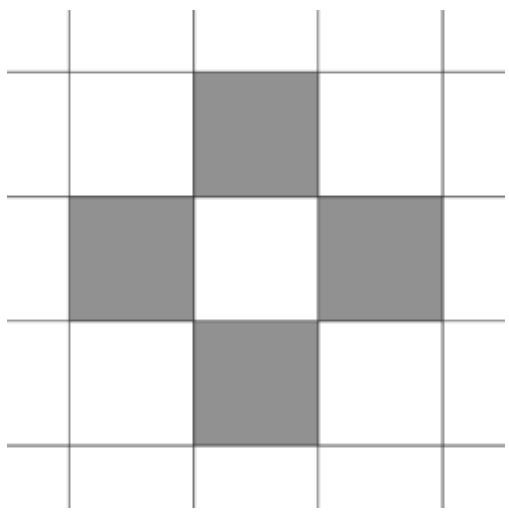
Figure 1: von Neumann neighborhood of 𝑟 = 1 A cell’s neighborhood can be defined as one of many types, with the von Neumann neighborhood being the most popular. The von Neumann neighborhood is composed of a central cell’s adjacent cells within a Manhattan distance of 𝑟 = 1 (Figure 1). This type of neighborhood is easily extended